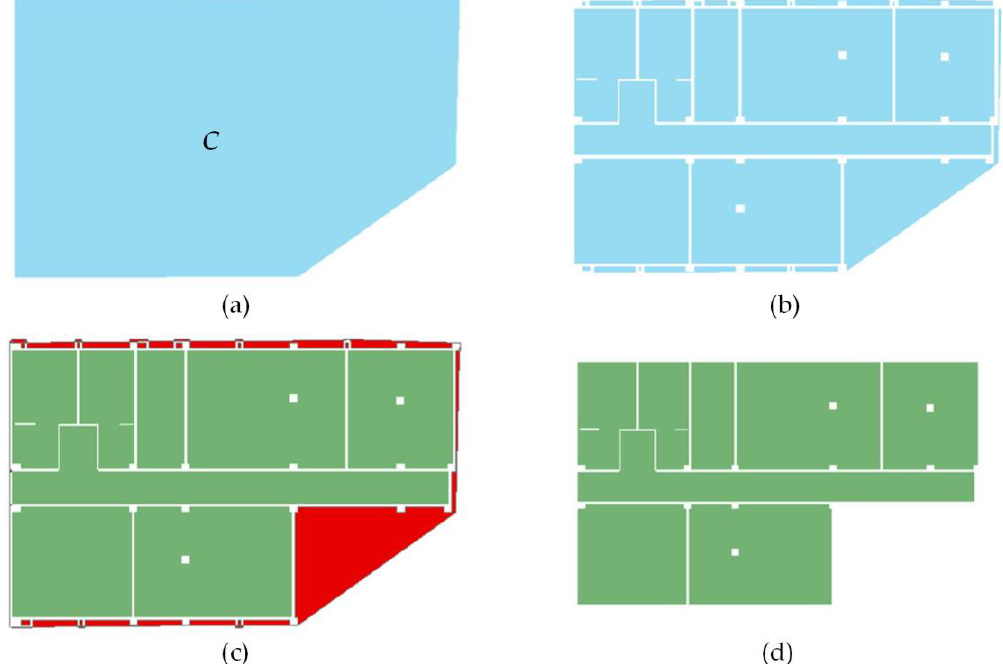
Figure 6. Extraction and modeling of single-floor building spaces in floor plan view: ( a ) convex hull C of S ; ( b ) result of the Boolean difference operation; ( c ) distinction between indoor and outdoor spaces, and ( d ) resulting indoor single-floor spaces.